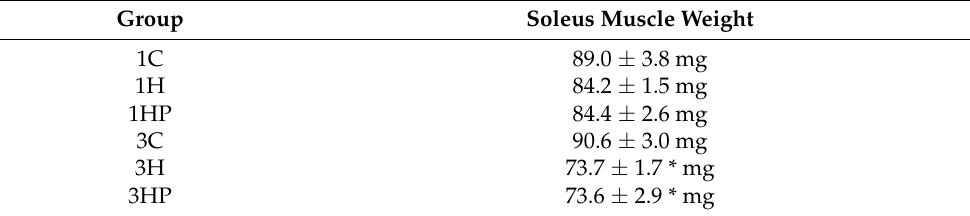
Table 1. Soleus Muscle